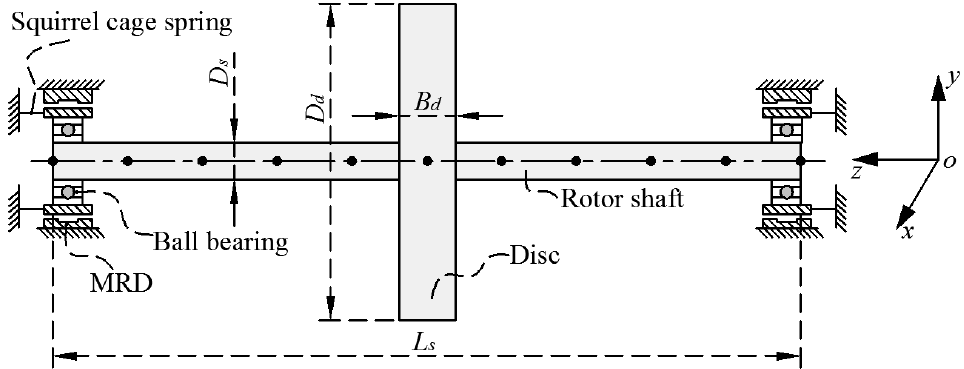
Figure 3. Schematic diagram of a general coupling system model of MRD-bearing-rotor with supporting of squirrel cage spring.